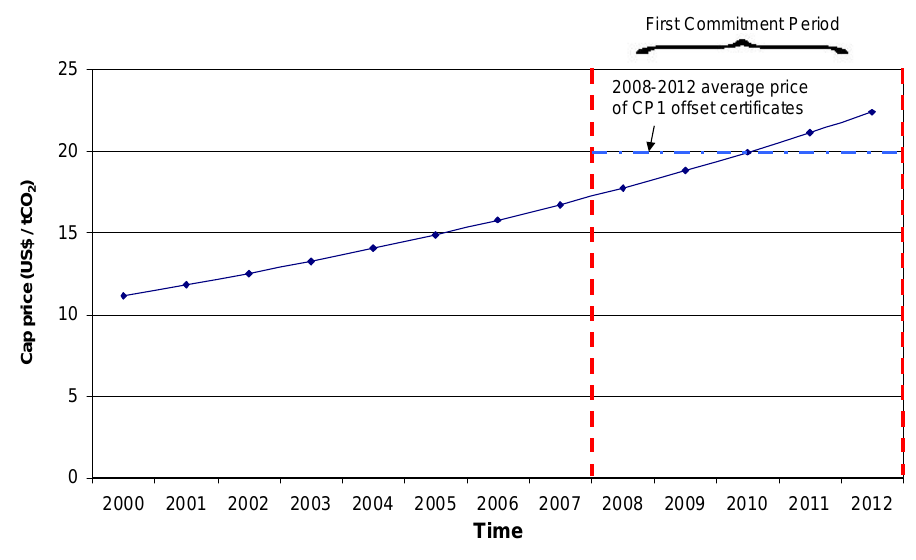
FIGURE 1. Increasing certificate price (CP1 = first commitment